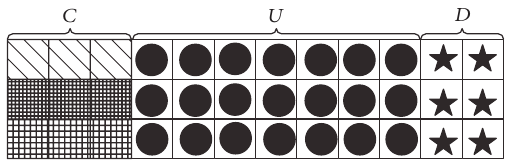
Figure 1: Conventional pilot scheme.